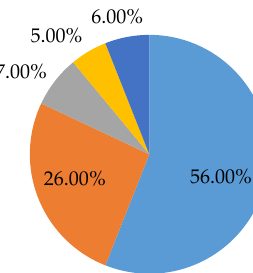
Figure 1. A mature field’s energy consumption structure.